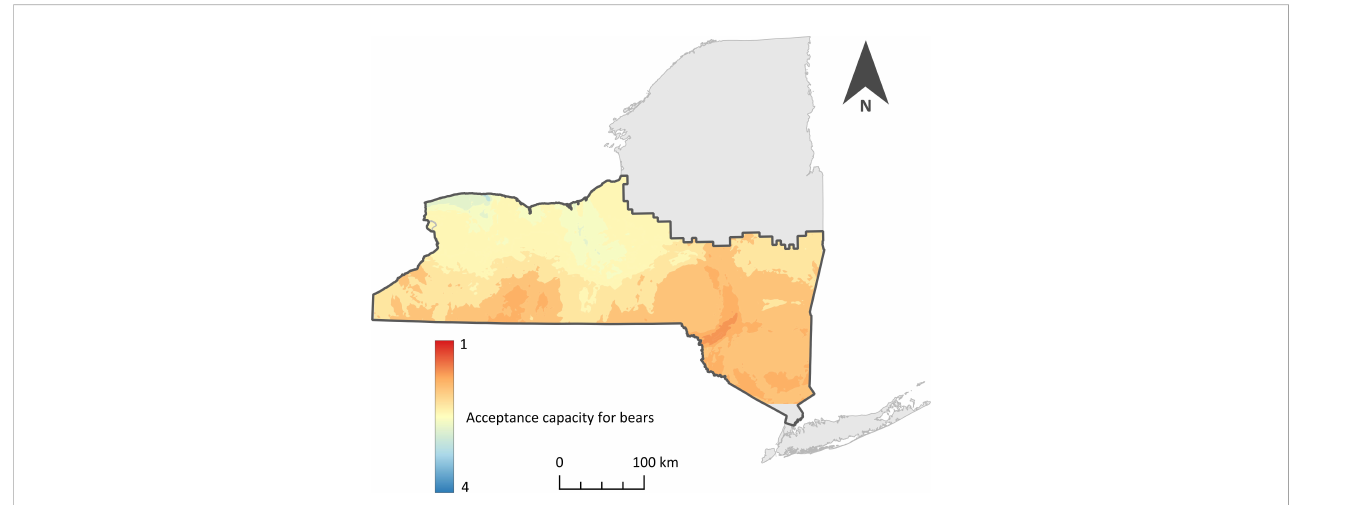
FIGURE 5 Acceptance capacity data, 2018 New York State Property owner survey (data from Siemer et al., 2019). Dark line delineates the study area perimeter. Data displayed as a moving average. All points within a given window are averaged for the location at the center of a circular window with 25 kilometer radius. Darker shading indicates lower acceptance capacity for black bears ( Ursus americanus)